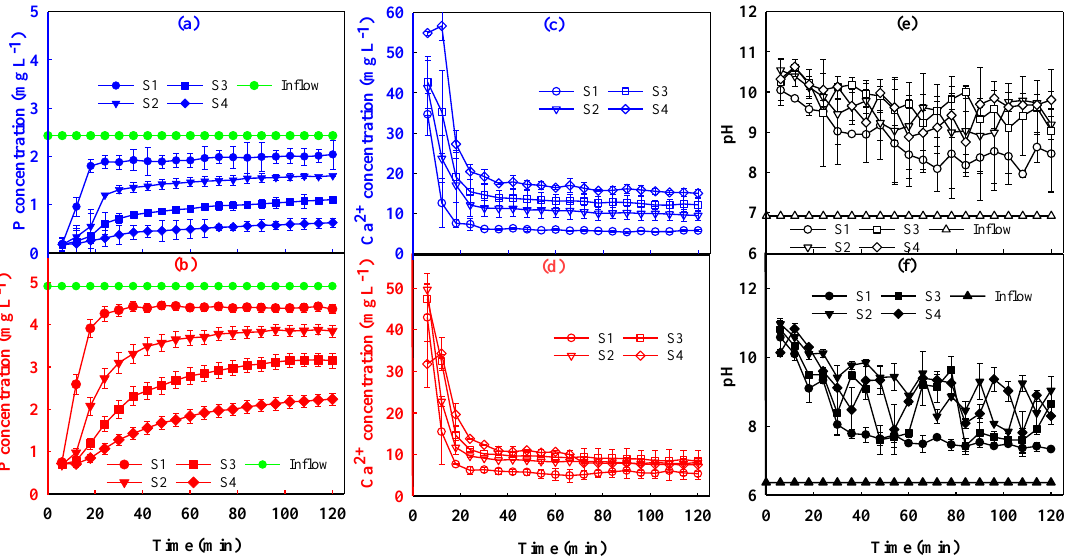
Figure 2. Phosphorus (P; ( a , b )), calcium (Ca; ( c , d )) concentrations, and pH ( e , f ) with time after treatment by each slag segment during the 2 h flow-through test. Figures ( a , c , e ) are for the inflow P treatment of 2.5 mg L − 1 and ( b , d , f ) are for 5.0 mg P L − 1 . The green line indicates inflow P concentrations. Table 2. The range and mean concentrations of phosphorus (P) and calcium (Ca 2+ ) and pH of treated water from each segment described in Table 1.